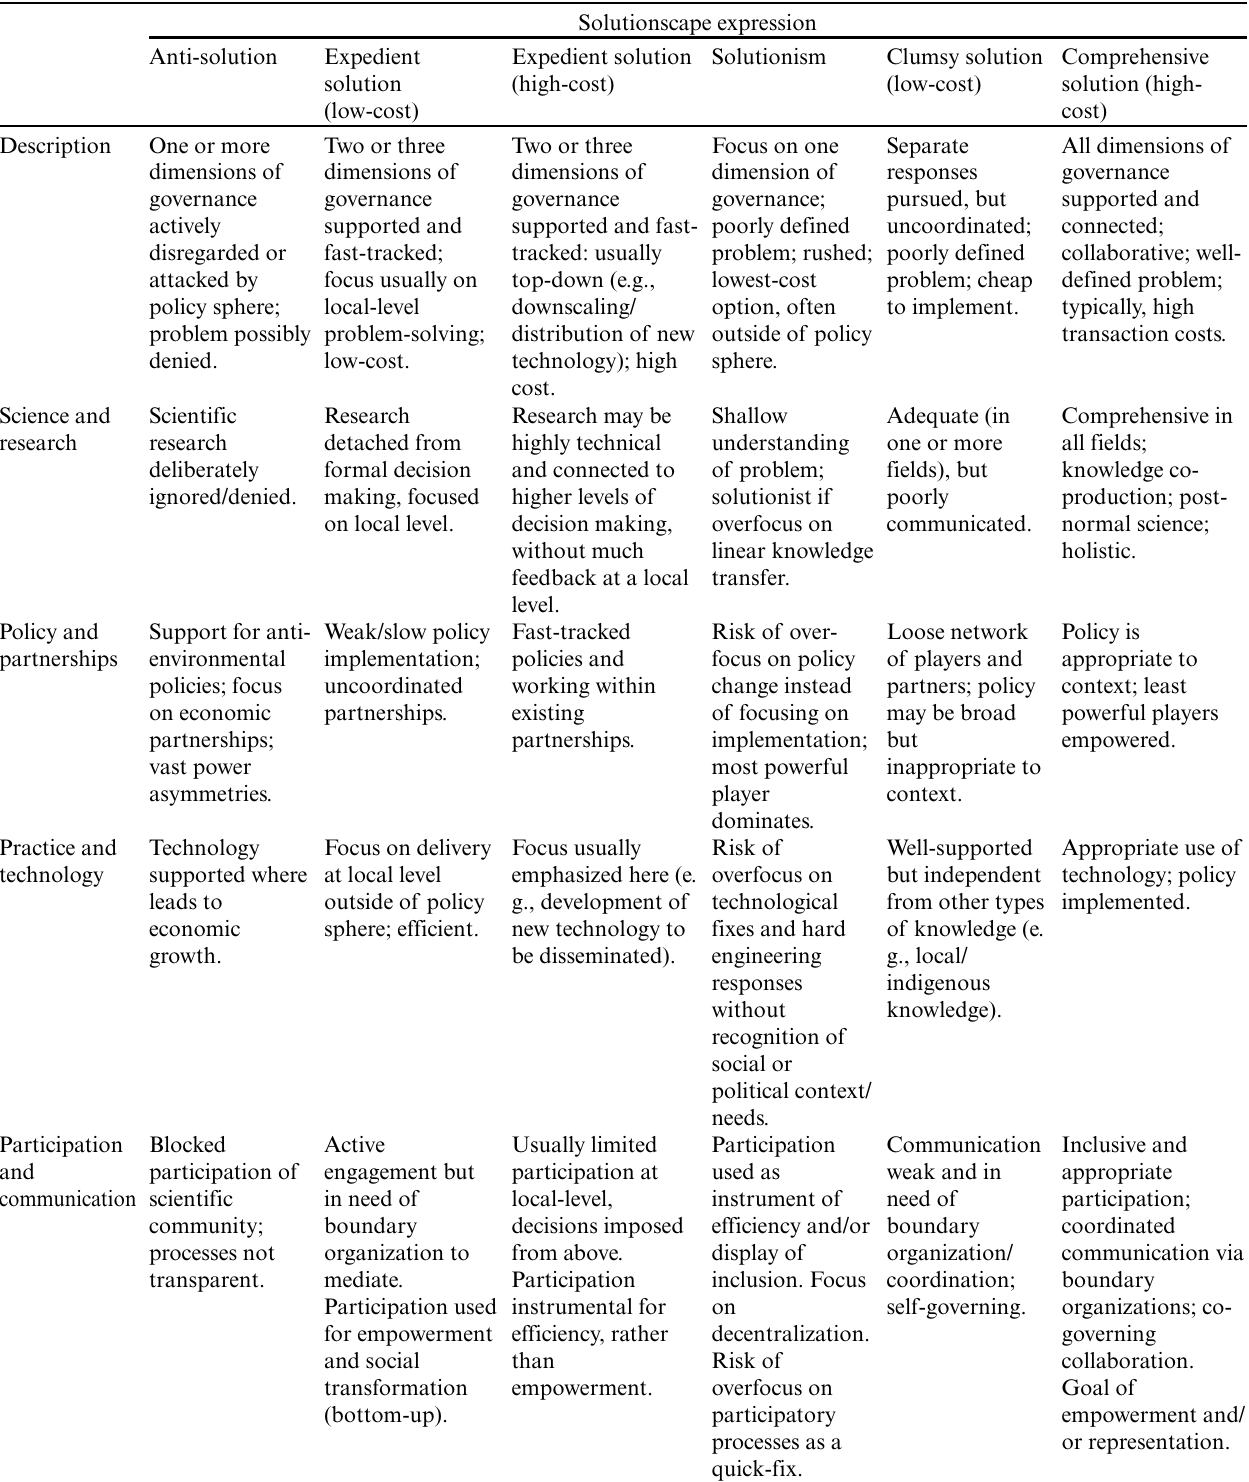
Table 1 . Key features of the ‘solutionscape’ and its